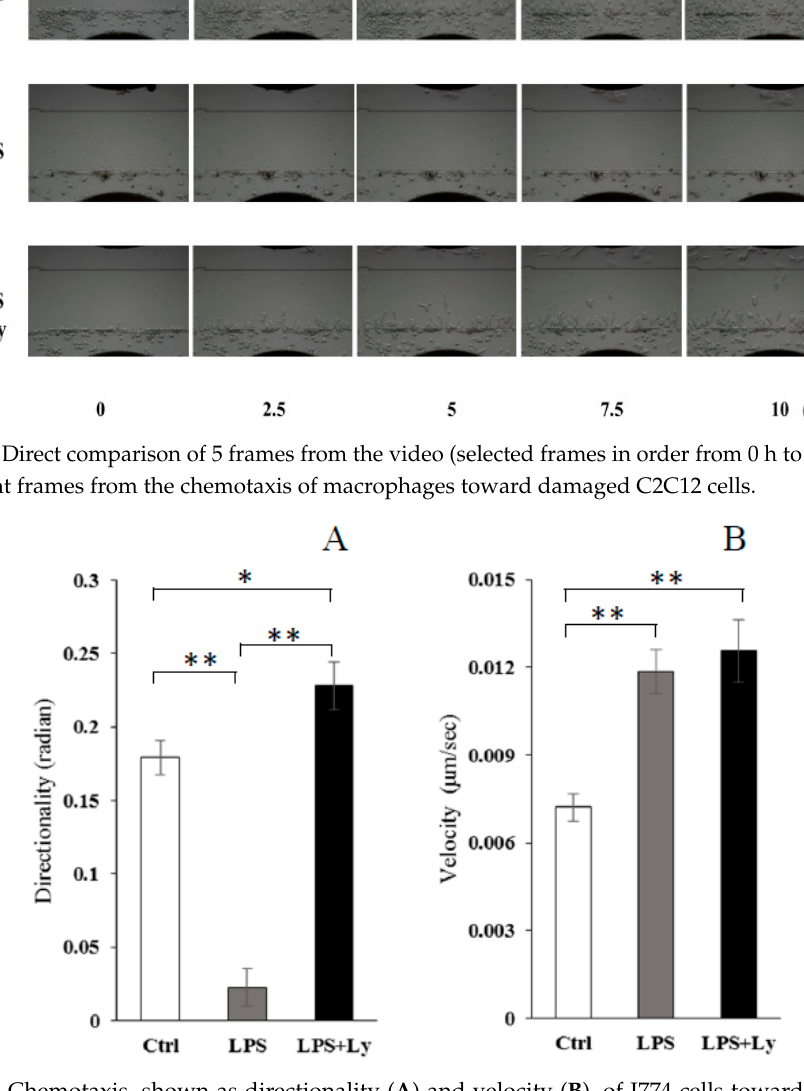
Figure 4. Chemotaxis, shown as directionality ( A ) and velocity ( B ), of J774 cells toward damaged C2C12 cells ( n = 100 for each condition). * p < 0.05 and ** p < 0.01.